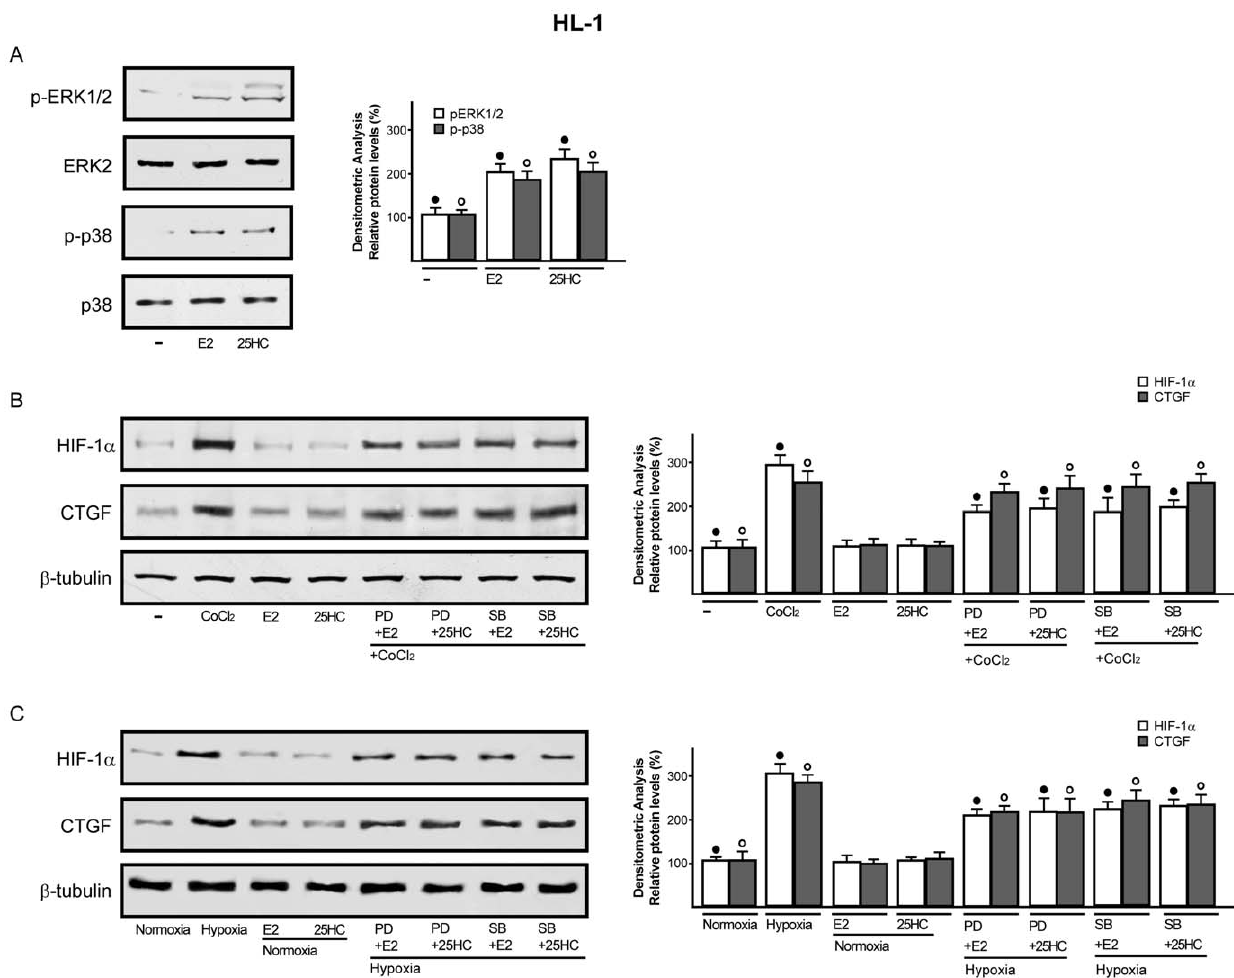
Figure 8. 25HC prevents the hypoxia-induced expression of HIF-1 a and CTGF through kinase-mediated signalling. (A) immunoblots of p-ERK1/2 and p-p38 from HL-1 cells treated for 10 min with vehicle (-), 10nM E2 and 1 m M 25HC. Total ERK/2 and p38 serve as loading control. (B) immunoblots of HIF-1 a and CTGF from HL-1 cells exposed for 8h to 100 m M CoCl 2 or hypoxia (2% O 2 ) (C), in combination with 10nM E2, 1 m M 25HC and 10 m M PD or 10 m M SB, as indicated. b -tubulin serves as loading control. Data (mean 6 SD) are representative of three independent experiments. Side panels show densitometric analysis of the blots, normalized to b -tubulin. ( N ), ( u ) indicate p , 0.05 for cells receiving vehicle (–) versus treatments or for cells cultured under normoxia versus cells exposed to